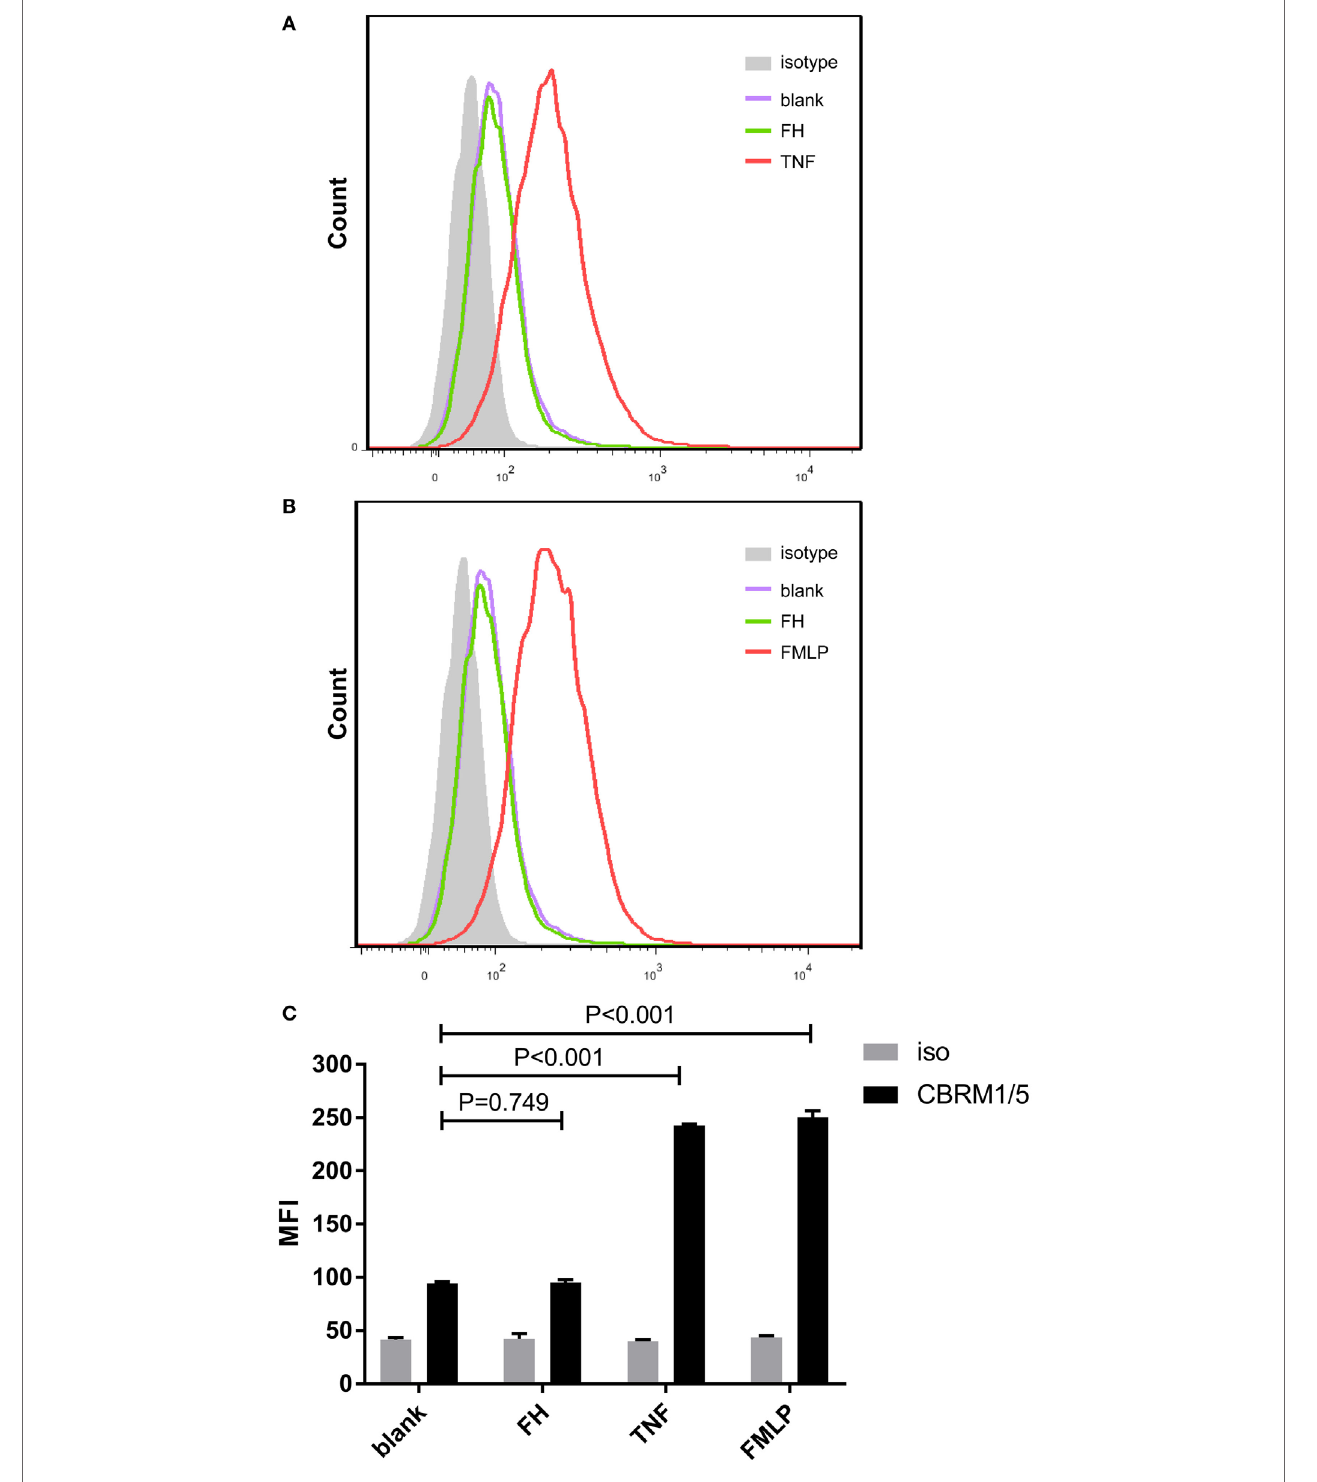
FigUre 2 | Binding of factor H (FH) to neutrophils do not activate CR3 (CD11b/CD18). Activate CR3 on neutrophils were detected using phycoerythrin-conjugated anti-CD11b monoclonal antibodies CBRM1/5 after incubation with FH, TNF- α , or fMLP. Unstimulated cells incubated with medium were set as blank controls. (a,B) Representative histograms showing that priming neutrophils with TNF- α or fMLP-induced expression of activate CR3, while FH did not activate CR3. (c) Analysis of expression of activate CR3. The expression level of active CR3 on nuetrophils after incubation with FH was comparable to unstimulated neutrophils. The values represent mean ± SD derived from three independent experiments.